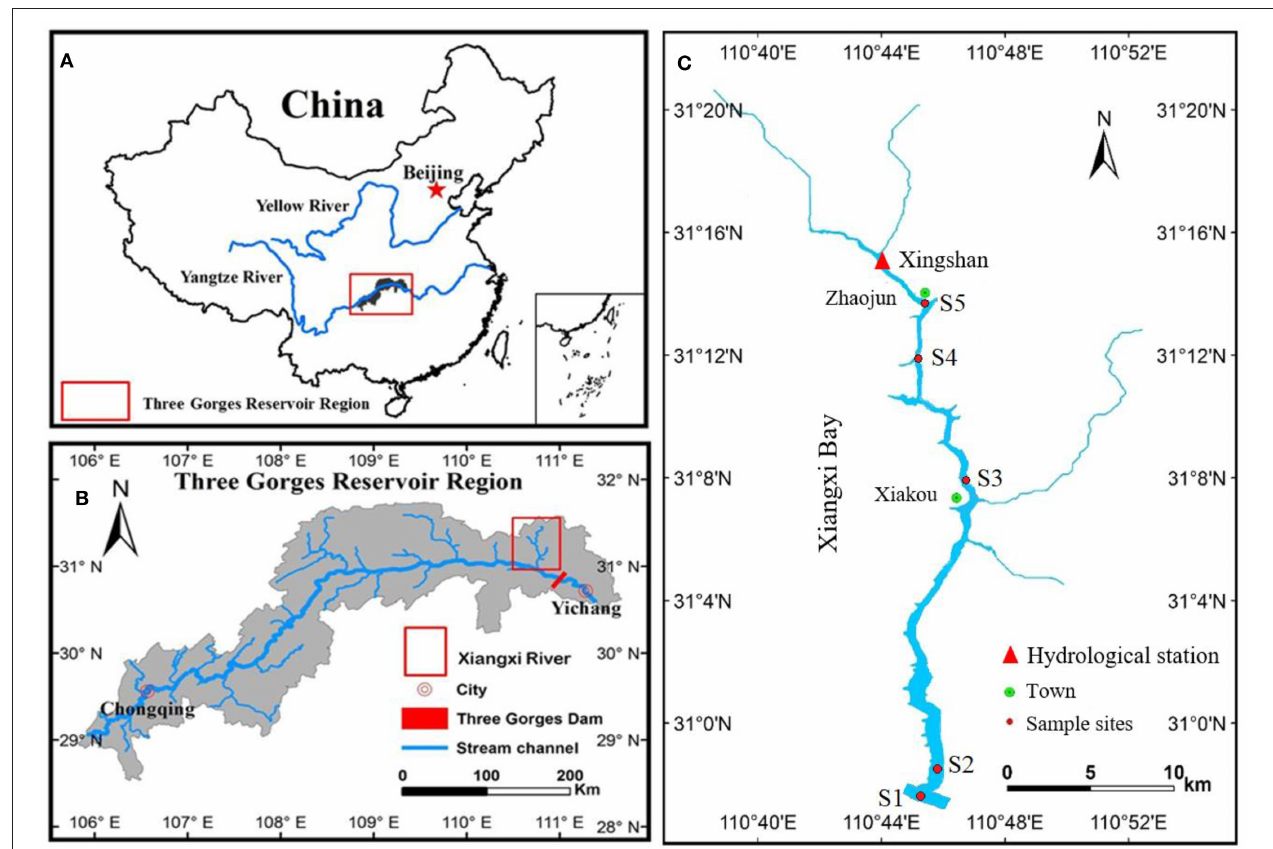
FIGURE 1 | (A) Location of the Three Gorges Reservoir (TGR) in China; (B) location of the Xiangxi Bay (XXB) in the TGR outlined in red and its drainage system; and (C) location of the sampling sites in the XXB.